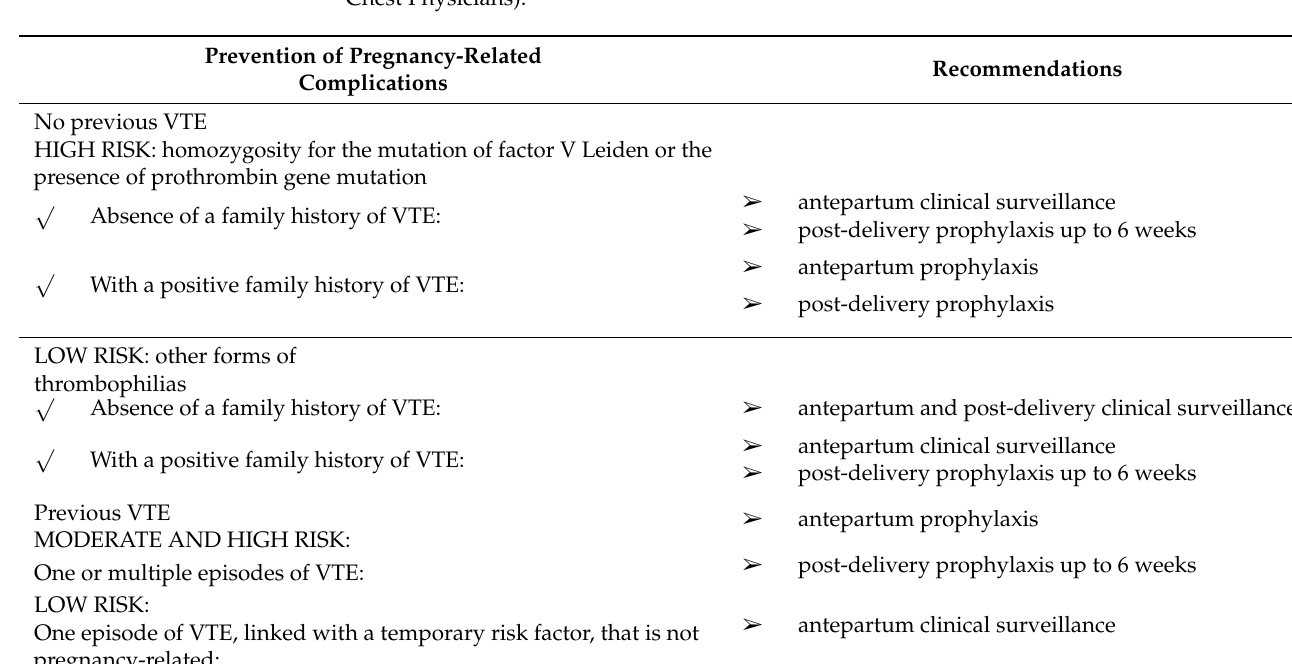
Table 1. Preferred prophylaxis in order to prevent pregnancy-related complications in women diagnosed with inherited thrombophilia—summary of recommendations (American College of Chest